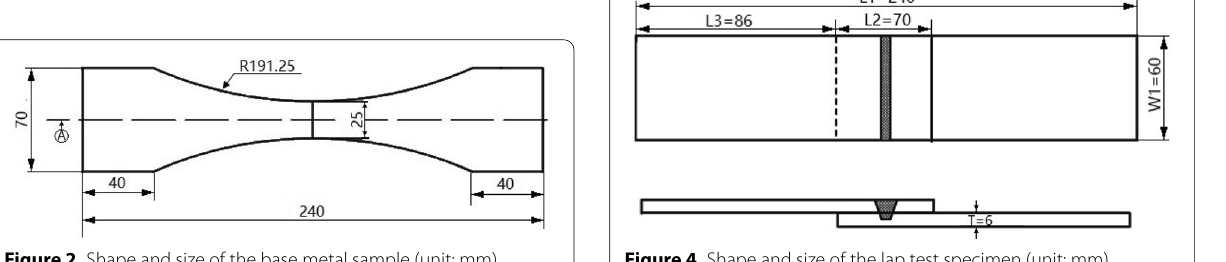
Figure 4 Shape and size of the lap test specimen (unit: